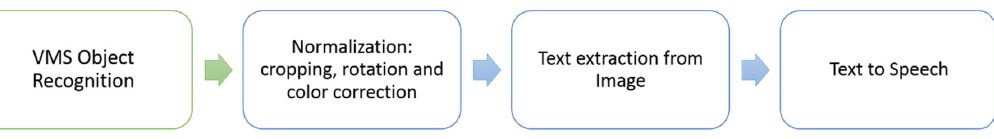
Figure 2. Processing steps.